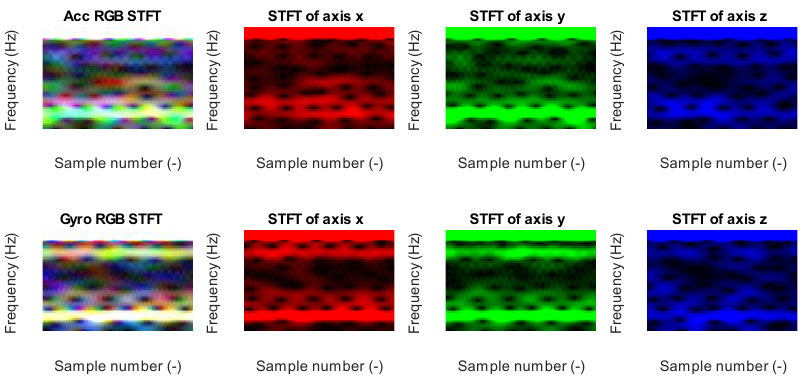
Figure 18. STFT RGB image of normal class for accelerometer x , y , and z axis ( top ) and gyroscope x , y , and z ( bottom ).